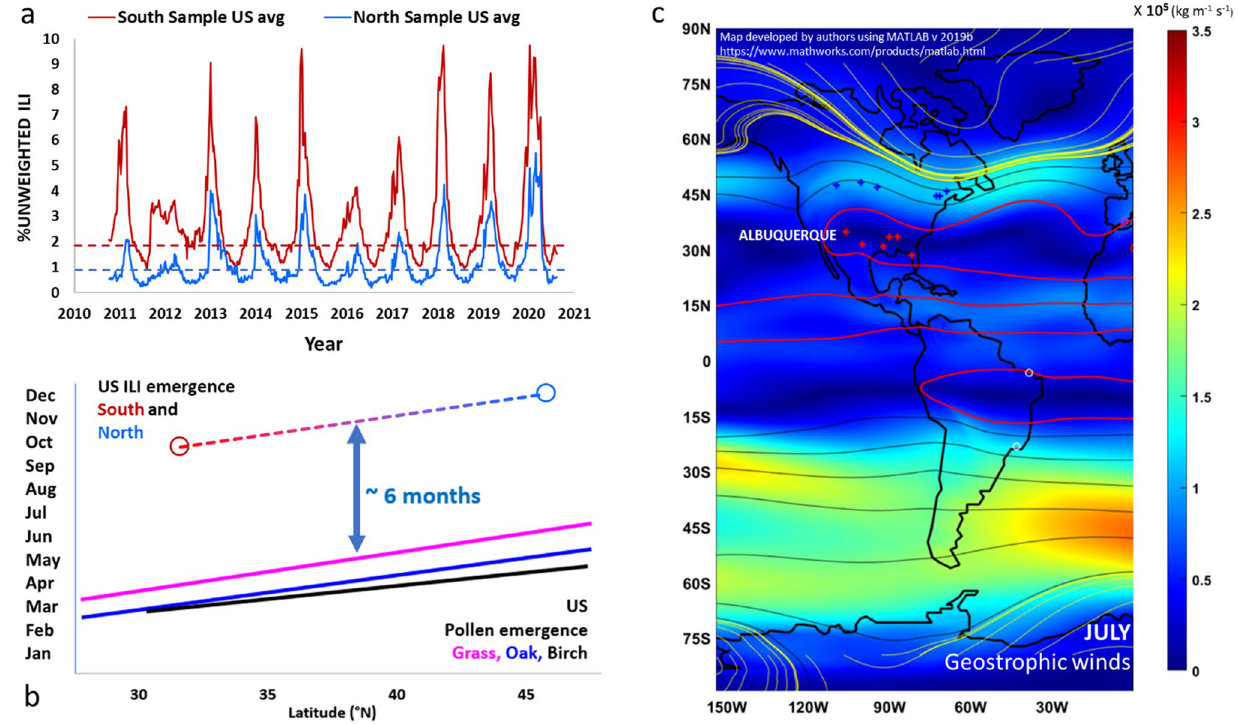
Figure 4. Comparison of ILI, pollen and geostrophic wind migrations. ( a ) Comparison of southern state ILIs averages to the northern state reported unweighted ILIs. Unweighted ILIs are the percentage of ILI diagnoses in comparison to all illness diagnoses from each sentinel site 32 . ( b ) Emergence dates for ILI and pollen across the US. (Adapted from references 32,36 ) ( c ). Geostrophic winds 35 with streamlines in July. Black lines originate from 0E. Red lines originate from 180W Yellow lines originate from 80N and